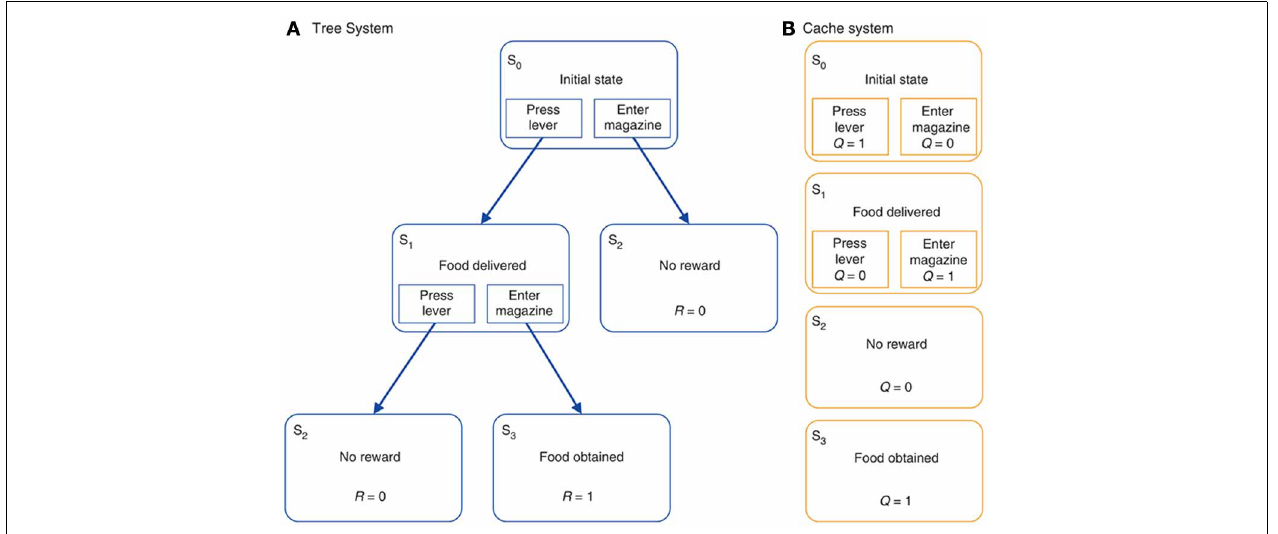
FIGURE 5 | A typical reinforcement learning task under either (A) goal-directed behavior (“model-based” reinforcement learning) or (B) habitual behavior (“model-free” or